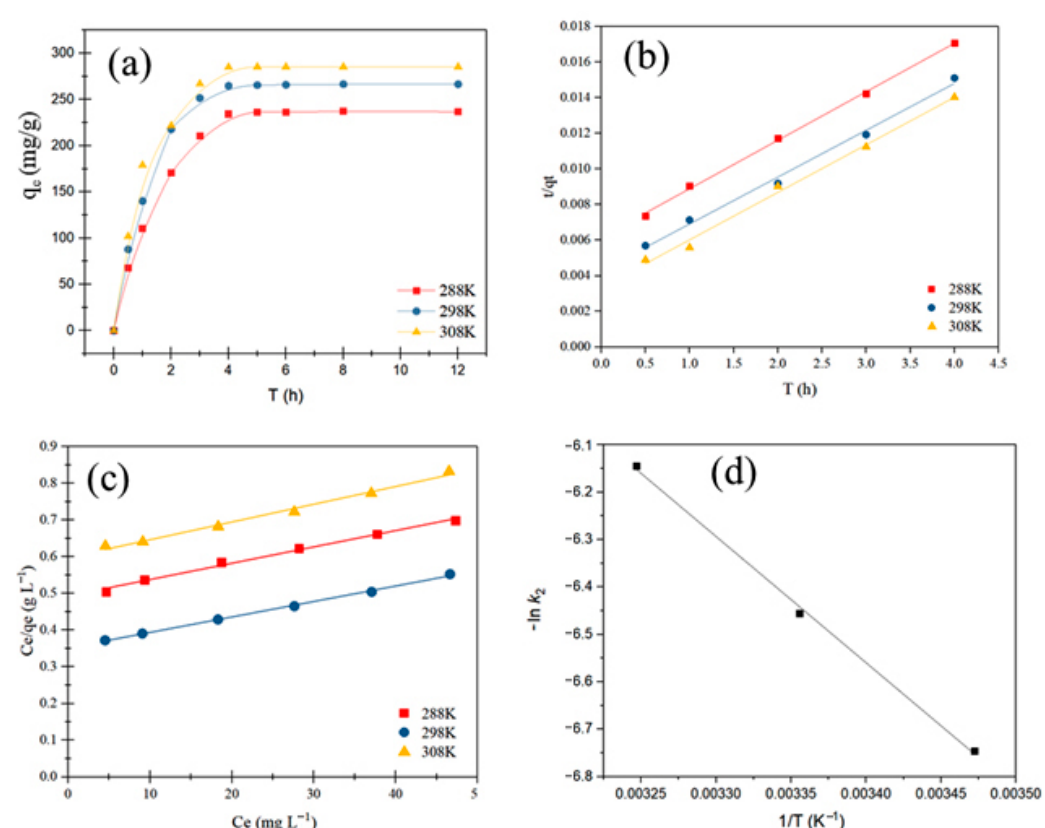
Figure 5. ( a ) Effect of temperature on the sorption kinetics of AQ2S; ( b ) Pseudo second-order kinetics of AQ2S at various temperature; ( c ) Linearized Langmuir isotherms for AQ2S adsorption at different temperature; ( d ) Determination of the activation energy for AQ2S adsorption.